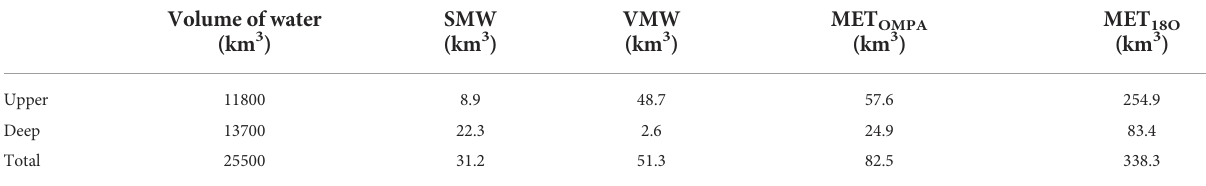
TABLE 2 Meltwater in the upper (<300 m) and deep layers of the Dotson-Getz Trough. SMW and VMW stand for submarine meltwater and ventilated meltwater,